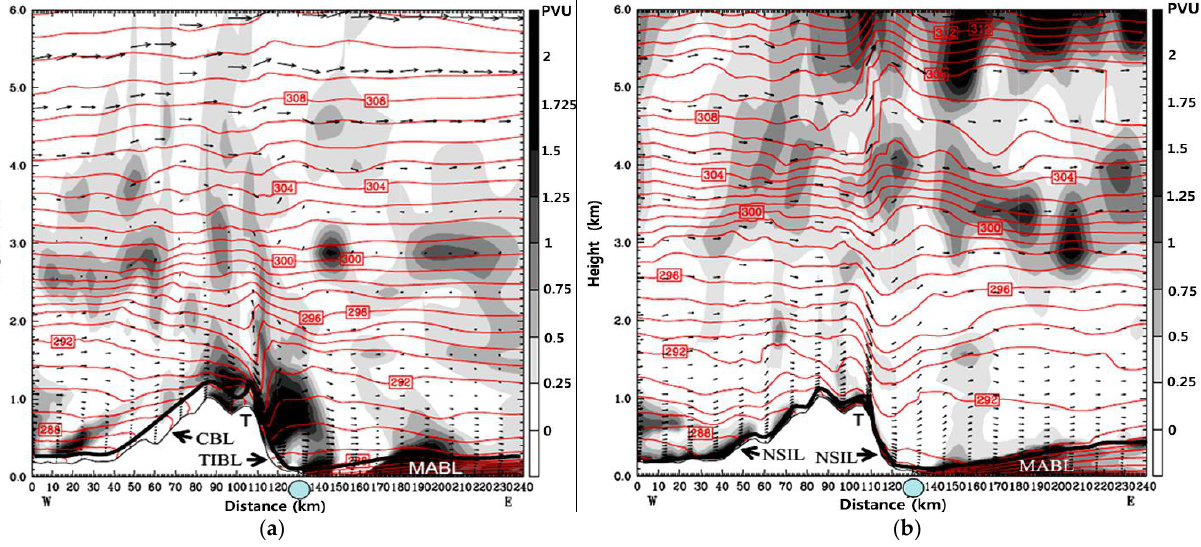
Figure 7 . Vertical profile of potential temperature (k) and wind speed (m/s) in the third domain of WRF-3.6 model simulation at ( a ) 09:00 LST, 29 March 2004, and ( b ) 21:00 LST. Thick line, CBL, TIBL, MAIL, NSIL, T, and a small circle on the bottom in ( a , b ) denote the top of the convective boundary layer, convective boundary layer, thermal internal boundary layer, marine atmospheric boundary layer, nocturnal surface inversion layer, Mt. Taegulyang, Gangneung city, respectively. The dark area of high potential vorticity near the surface in the coastal and open seas denotes trapped air particles, which are well matched with high PM concentrations [29].